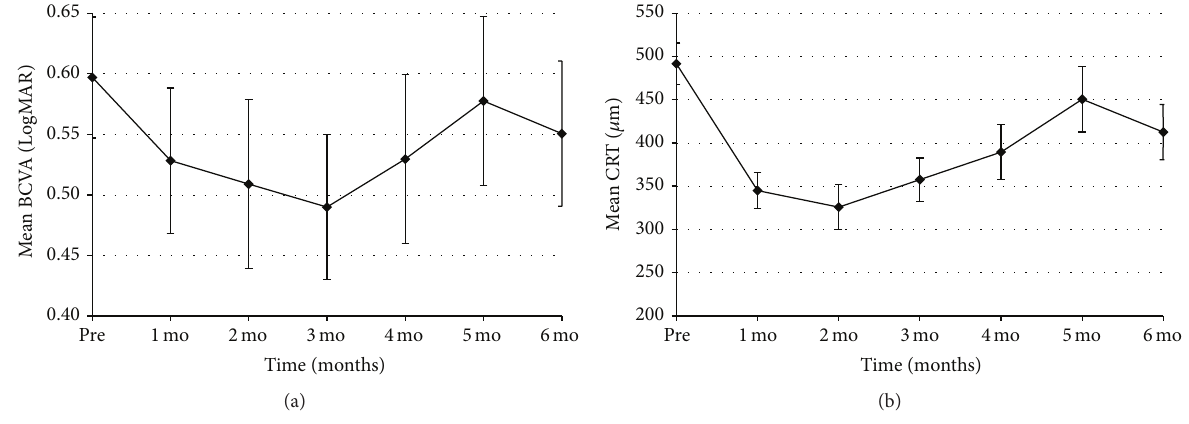
Figure 1: Mean changes in the LogMAR BCVA and CRT in the study eyes.